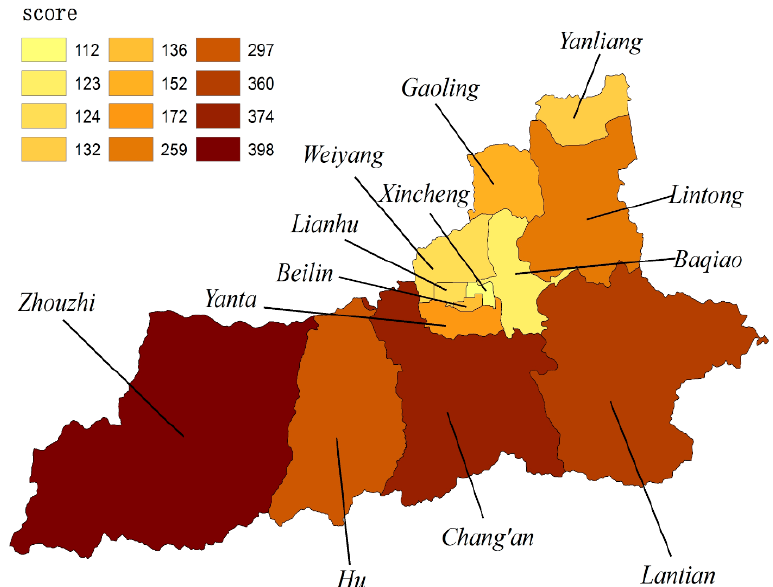
Figure 7. The score after being weighted for indicators.